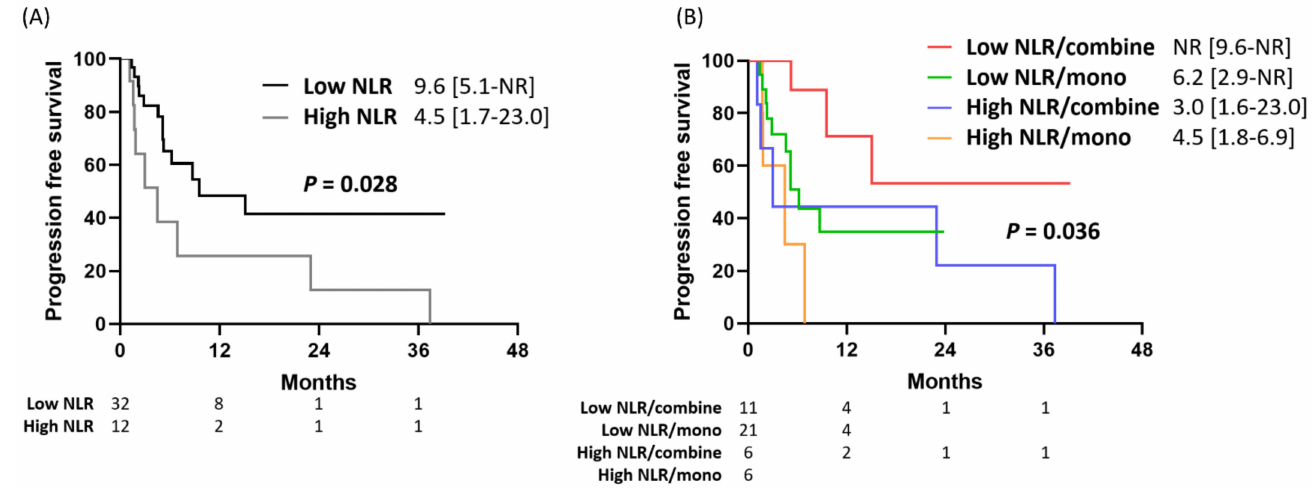
Figure 3. ( A ) The progression-free survival among patients with high/low NLR. ( B ) The progression- free survival among patients with high/low NLR and received combination/monotherapy. NA— not